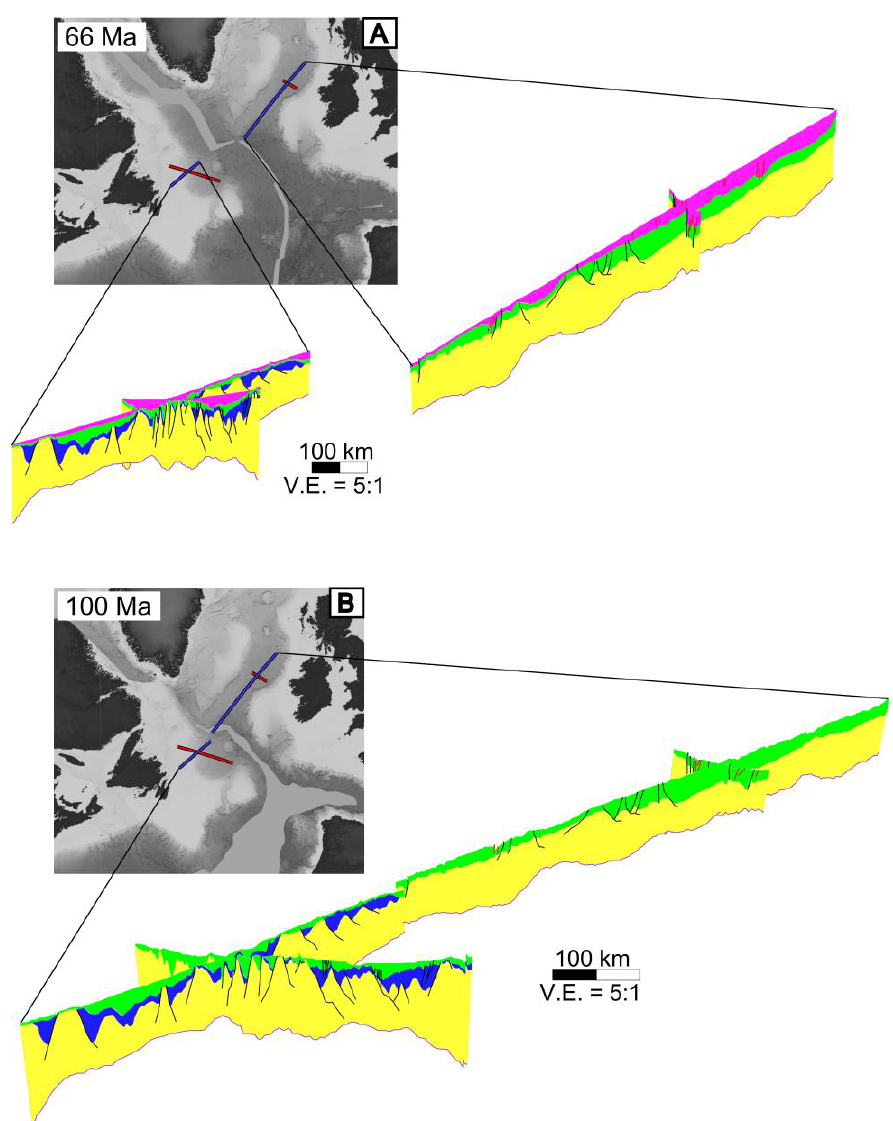
Figure 8. ( A ) Model in GPlates of the Newfoundland-Ireland conjugate margins with modern bathymetry reconstructed to 66 Ma with 3D model of seismic lines NL1 and NL2 (left) in the Orphan Basin and 3D model of seismic lines IR1 and IR2 (right) in the Rockall Basin with the Upper Cretaceous sedimentary sequence decompacted and thermal subsidence restored. ( B ) Model in GPlates of the Newfoundland-Ireland conjugate margins with modern bathymetry reconstructed to 100 Ma with 3D model of seismic lines NL1 and NL2 (left) in the Orphan Basin and of seismic lines IR1 and IR2 (right) in the Rockall Basin with the Lower Cretaceous sequence decompacted and thermal subsidence restored. Black lines represent primary faults and red lines represent secondary faults. For meaning of layer colours, see legend in Figure 6.